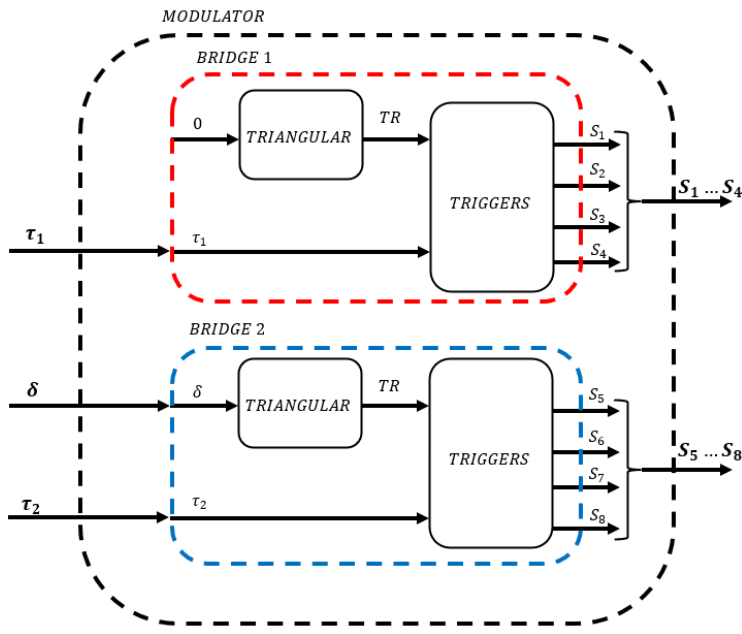
Figure 11. Block diagram of the modulator.